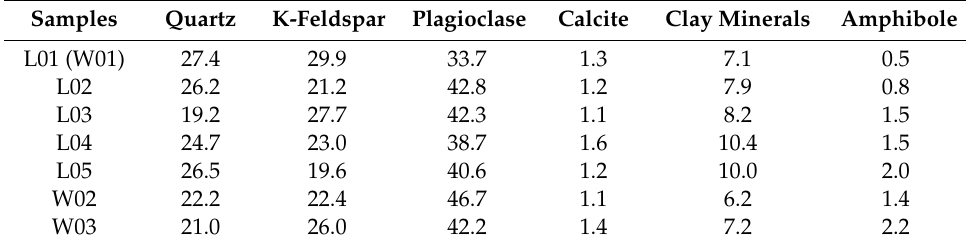
Table 2. Results of mineral analysis by using X-ray di ff raction of soil